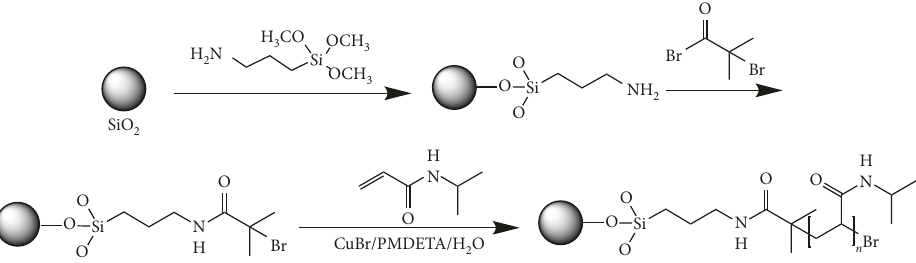
Figure 2: The schematics of the grafting procedure of PNIPAM on SiO